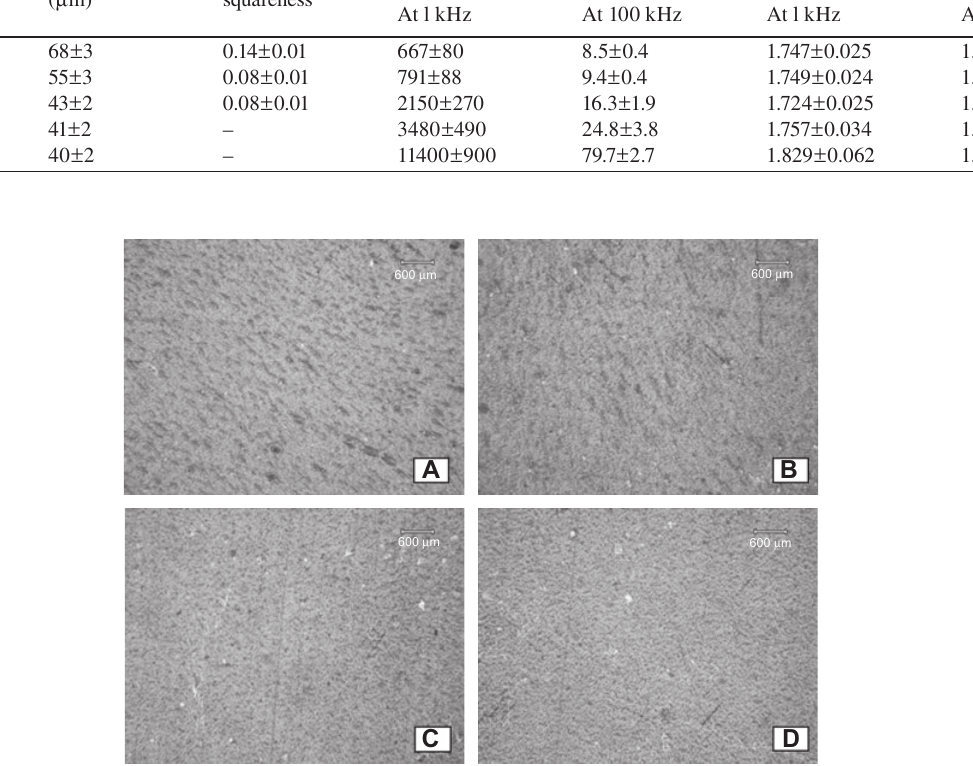
Figure 1 Optical micrograph of PVDF composites with 10 wt % Ni prepared from spin coating speeds of (A) 750 (B) 1500 (C) 3000 and (D) 3750